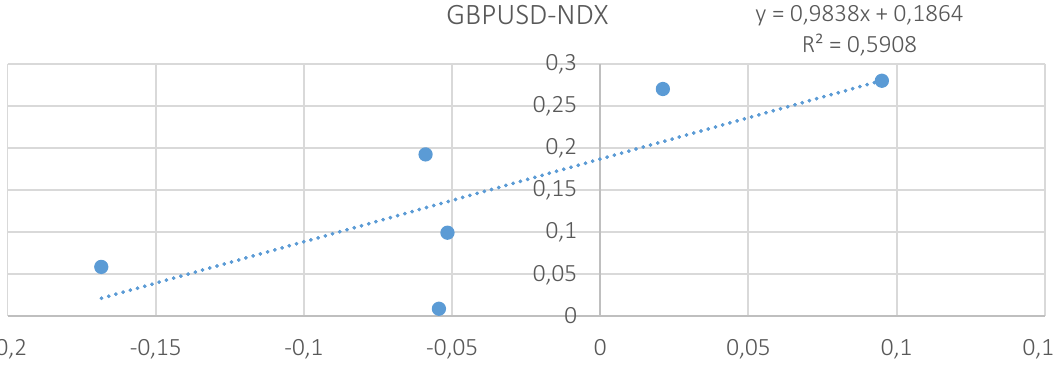
Figure 11. Regression line of GBPDN and